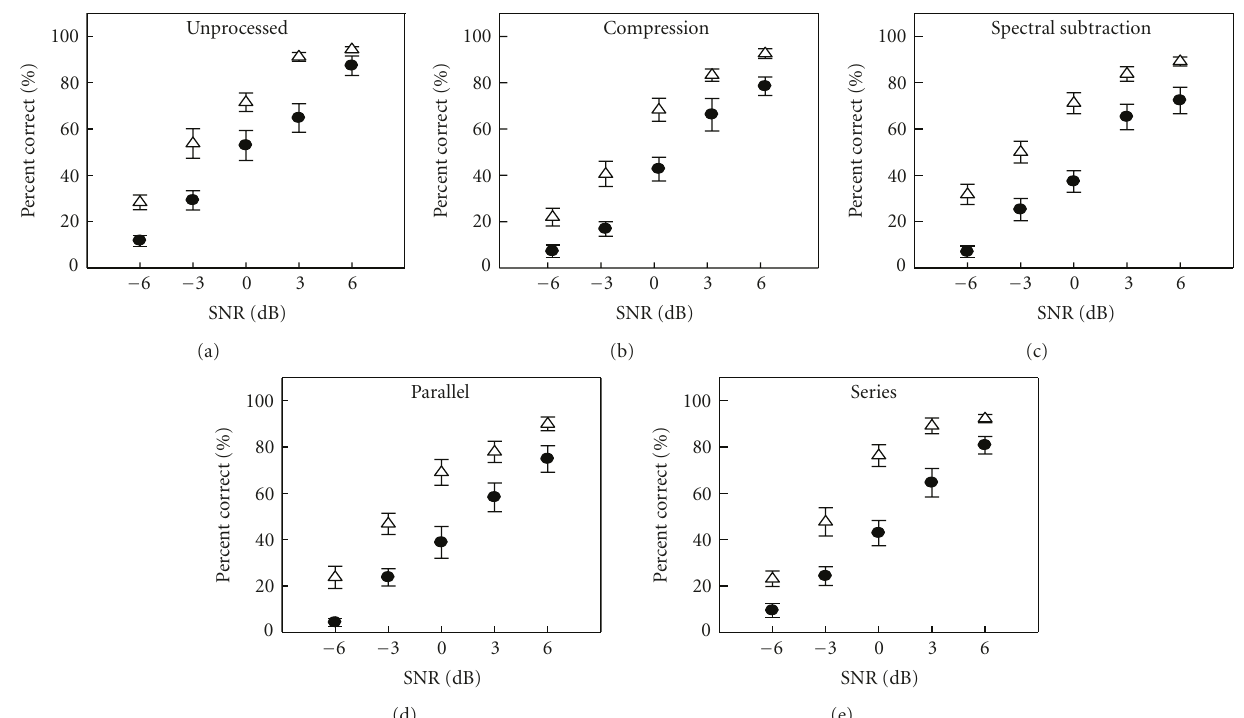
Figure 6: Intelligibility scores (in percent correct) for listeners with normal hearing (open triangles) and listeners with hearing loss (closed circles) grouped by processing condition. Error bars represent the standard